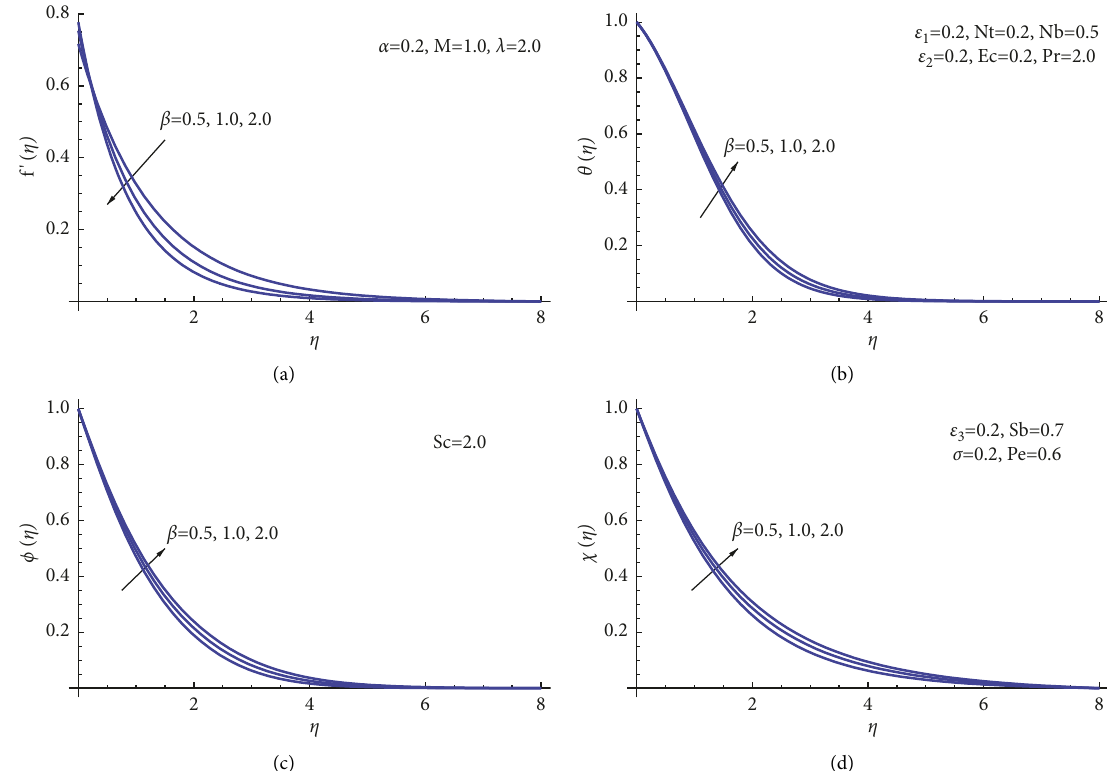
Figure 5: (a) Impact of β on f ′ ( η ) . (b) Impact of β on θ ( η ) . (c) Impact of β on ϕ ( η ) . (d) Impact of β on χ ( η ) .